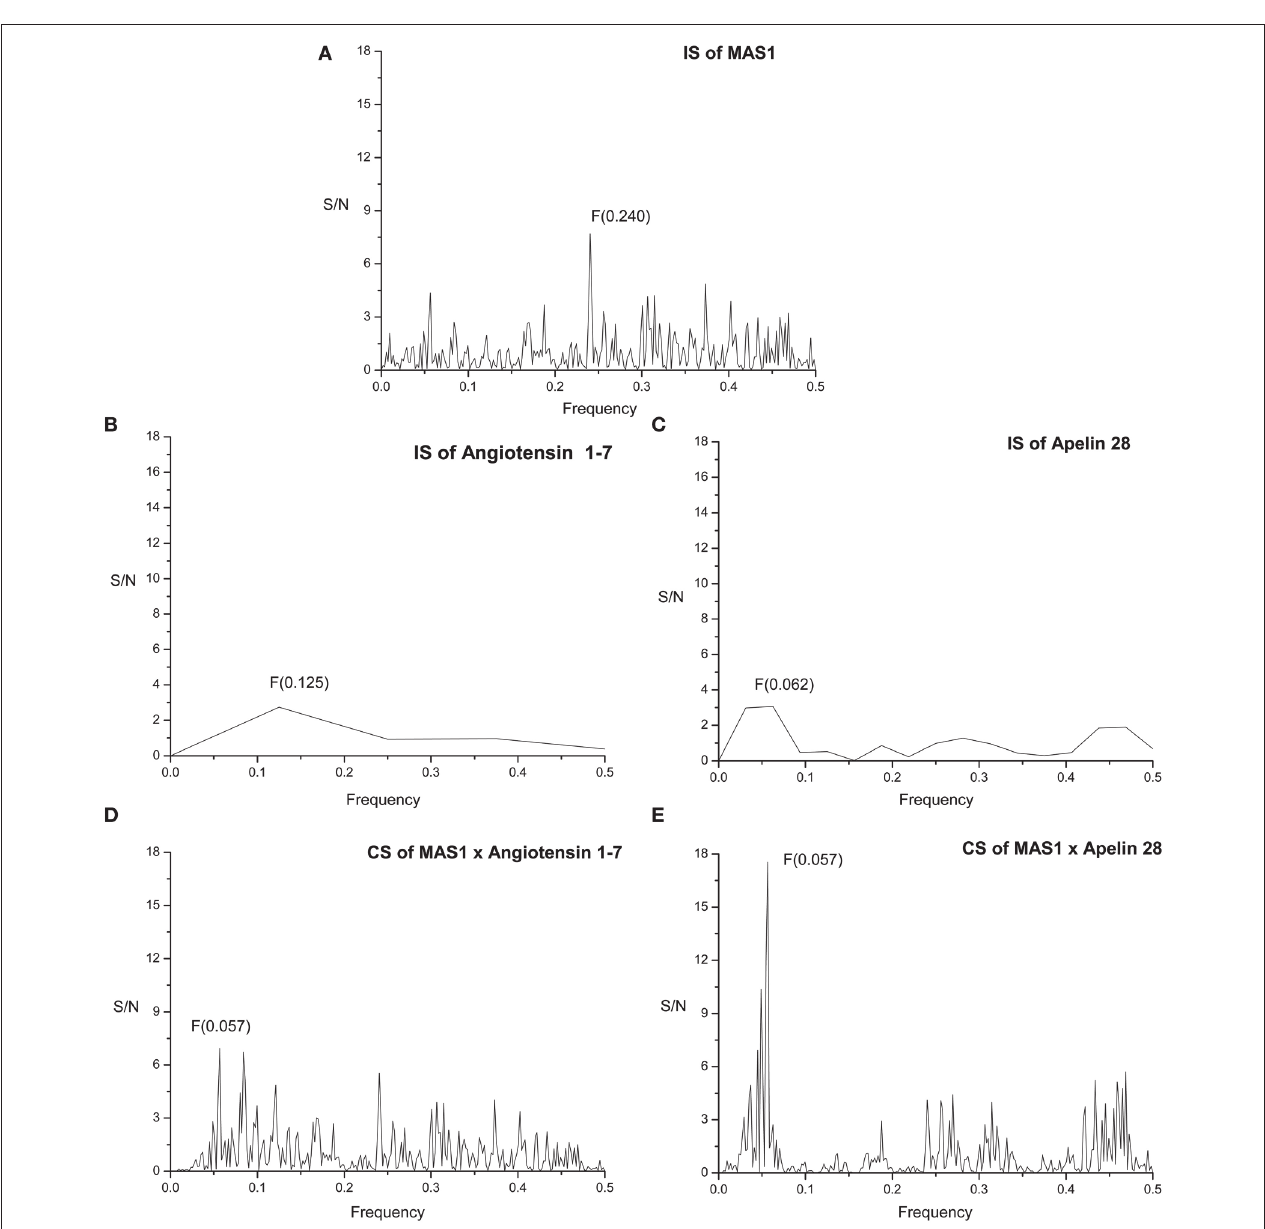
FIGURE 2 | Informational spectrum (IS) of (A) MAS1, (B) angiotensin 1-7, (C) apelin 28, and consensus informational-spectrum (CIS) of (D) MAS1 and angiotensin 1-7 and (E) MAS1 and apelin.